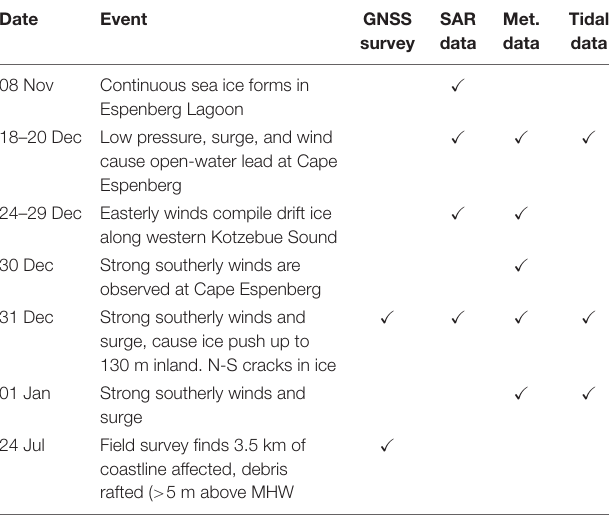
TABLE 2 | Chronology of events and supporting